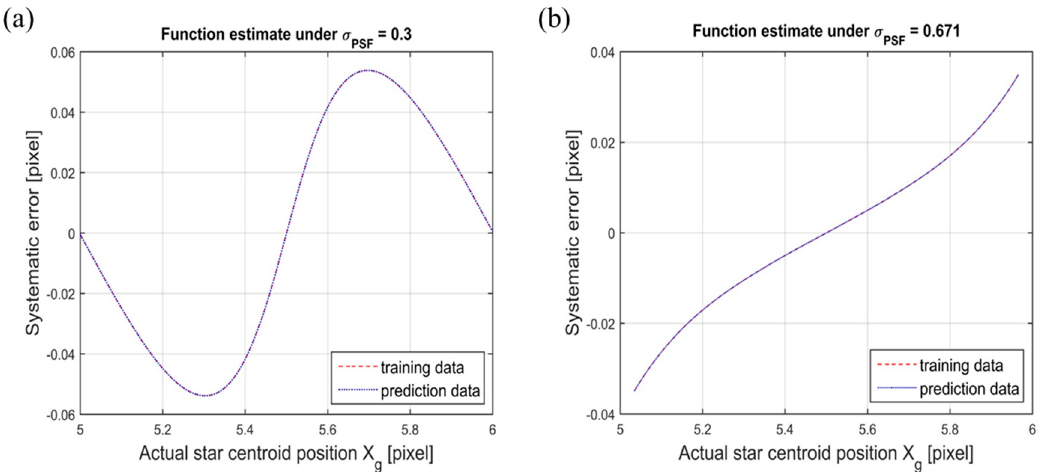
Figure 9. The fitting error of the BA-ELM compensation method. ( a ) Gaussian width 𝜎 (cid:3017)(cid:3020)(cid:3007) = 0.3. ( b ) Gaussian width 𝜎 (cid:3017)(cid:3020)(cid:3007) = 0.671. 4.3. The Prediction Accuracy of the BA-ELM The high fitting accuracy in the training samples cannot illustrate the performance of the BA- ELM model comprehensively. In practical operations, the BA-ELM is to be utilized to predict the systematic error of the star centroid at random positions. Therefore, the prediction accuracy is a critical parameter to evaluate the BA-ELM model. Firstly, the prediction accuracy is defined in this section.